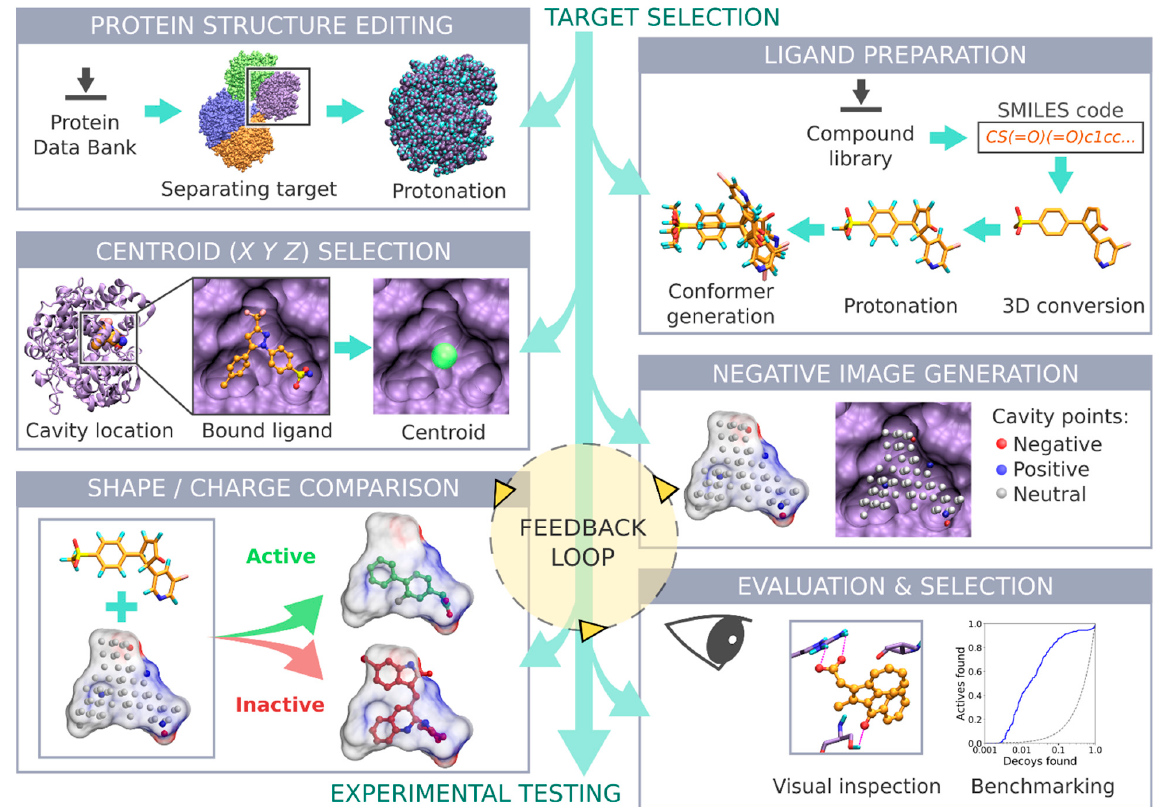
Figure 1. Negative image-based screening. The steps of a negative image-based (NIB) [1] screening or cavity-based rigid docking, which is presented using cyclooxygenase-2 (COX-2; Protein Data Bank (PDB): 3LN1 [2]; A chain) as a model system, include ligand preparation, protein 3D structure editing, cavity centroid ( X Y Z ) selection, negative image or NIB (negative image-based) model generation with PANTHER [3], geometry optimization or rigid docking with shape / charge comparison using ShaEP [4], visual evaluation of the highest scored ligand poses against the protein structure (e.g., BODIL [5]), and potential benchmark testing with the known ligand sets (e.g., ROCKER [6]) before the virtual screening against a commercial compound database, compound selection, and in vitro testing. In the receiver operating characteristics (ROC) plot, the blue line designates the NIB enrichment, and the dashed line outlines the random selection with the area under curve (AUC) value of 0.50. In the NIB screening, a negative image is built based on the target protein’s ligand-binding cavity shape and electrostatics (Figure 1). The NIB model ideally encompasses those key shape features of the target’s cavity required for the potent ligand binding. The NIB model generation, which is done using the cavity detection software PANTHER [3], takes into account explicit water molecules, cofactors and ions, user-defined restrictions, and alternative residue protonation. A NIB model can be built based solely on protein 3D structure information (Figure 1) and, thus, without prior knowledge on target-specific active and inactive ligands. The resulting NIB model functions as a template or pseudo-ligand directly in the shape/electrostatics similarity comparison against ligand 3D conformers included in the screening compound libraries. The ligand preparation and similarity comparison against the model (Figure 1) is done using established ligand-based screening tools [4,7]. Whereas standard flexible docking relies on estimating the favorability of ligand-receptor complexes by summing up the weak interactions, such as hydrogen bonding and the hydrophobic effect, the NIB focuses squarely on the shape/electrostatics similarity of the molecular recognition process. Despite the apparent simplicity of this shape-centric approach, the benchmarking has shown